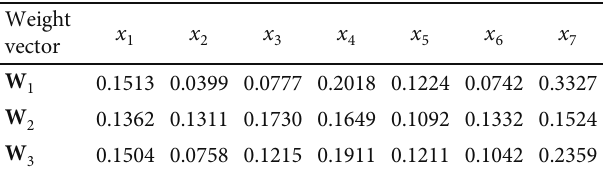
Table 3: Weights determined by the analytic hierarchy process, the entropy weight method, and the comprehensive weight method. Weight